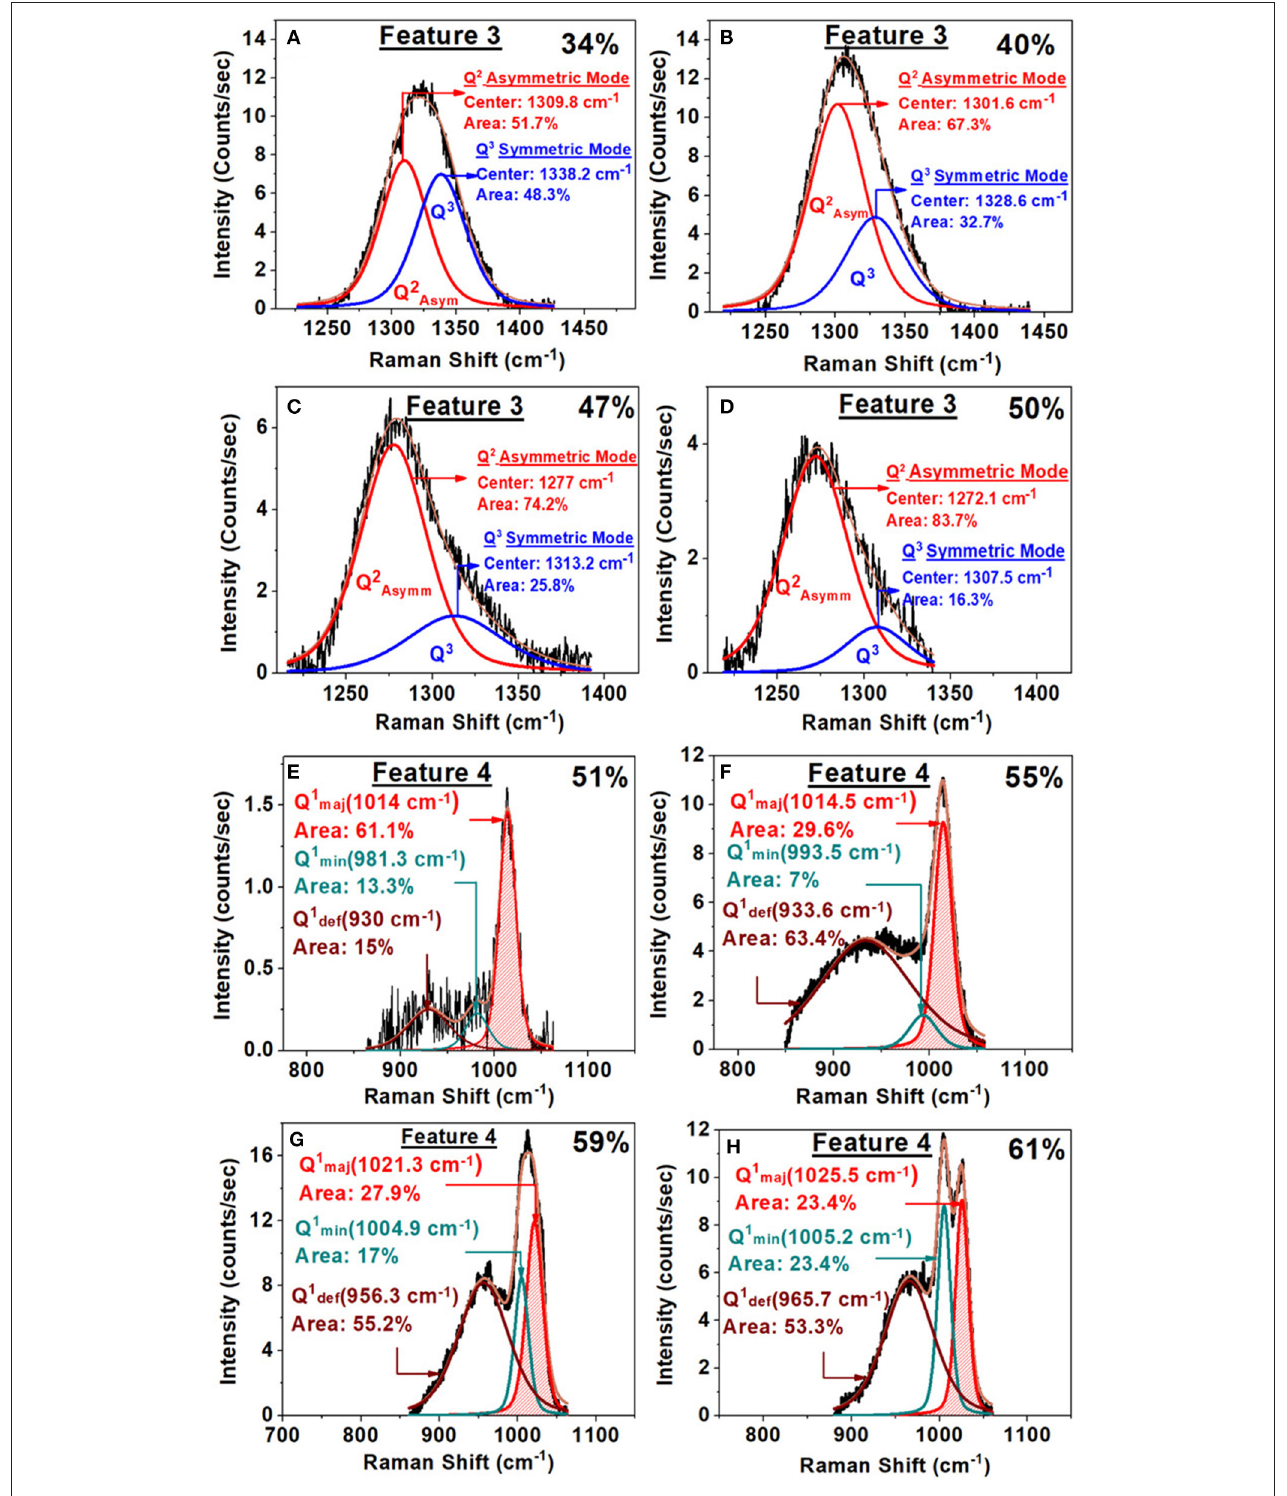
FIGURE 11 | (A–D) Examples of a Raman lineshape analysis of feature 3 associated with the Q 3 local structure in SPGs with increasing x. Note that as x increases the Q 3 related vibrational mode scattering strength steadily decreases. (E–H) Examples of Raman lineshape feature 4 deconvolution associated with the Q 1 local structure (mode near 1,012 cm − 1 ) in SPGs as a function of glass composition. Note that the scattering strength of the mode in question increases steadily with composition in the 50% < x < 59%.